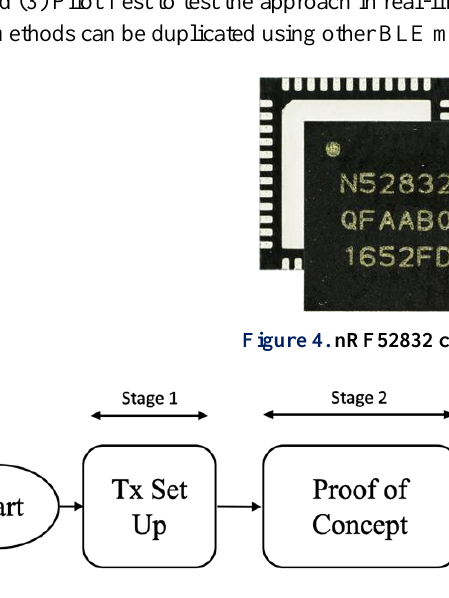
Figure 5. Overall Experimentation